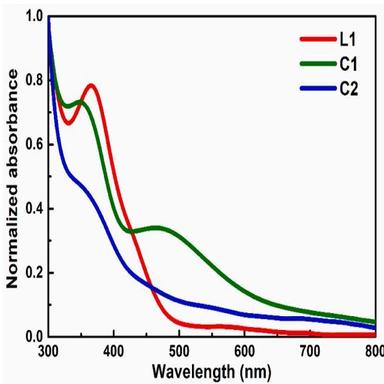
Normalized absorption spectra of studied L1, C1 and C2 thin films.